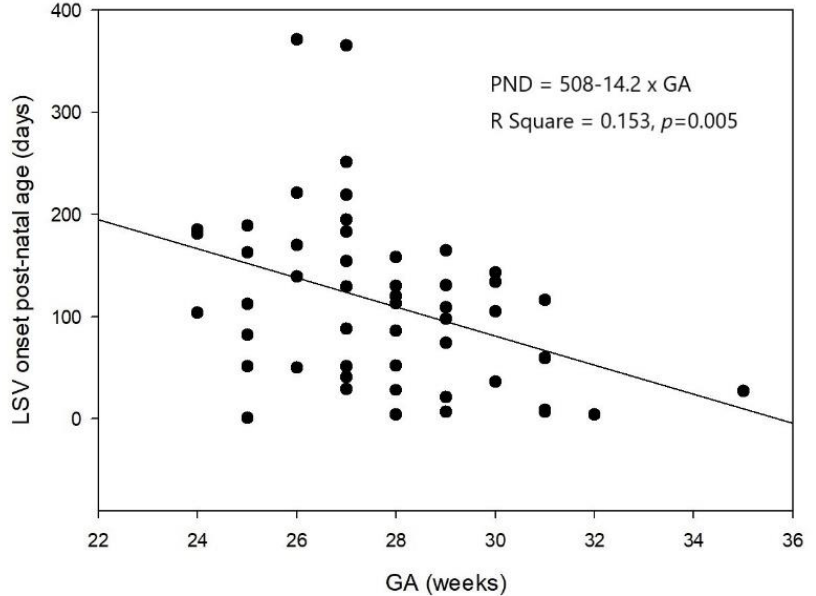
Figure 2. The negative association between the first postnatal days when lenticulostriate vasculopathy was first detected and gestational age analyzed by linear regression analyses ( n = 51, R 2 = 0.153, p = 0.005). Table 1. Presentations and evolution of LSV in very-low-birth-weight preterm